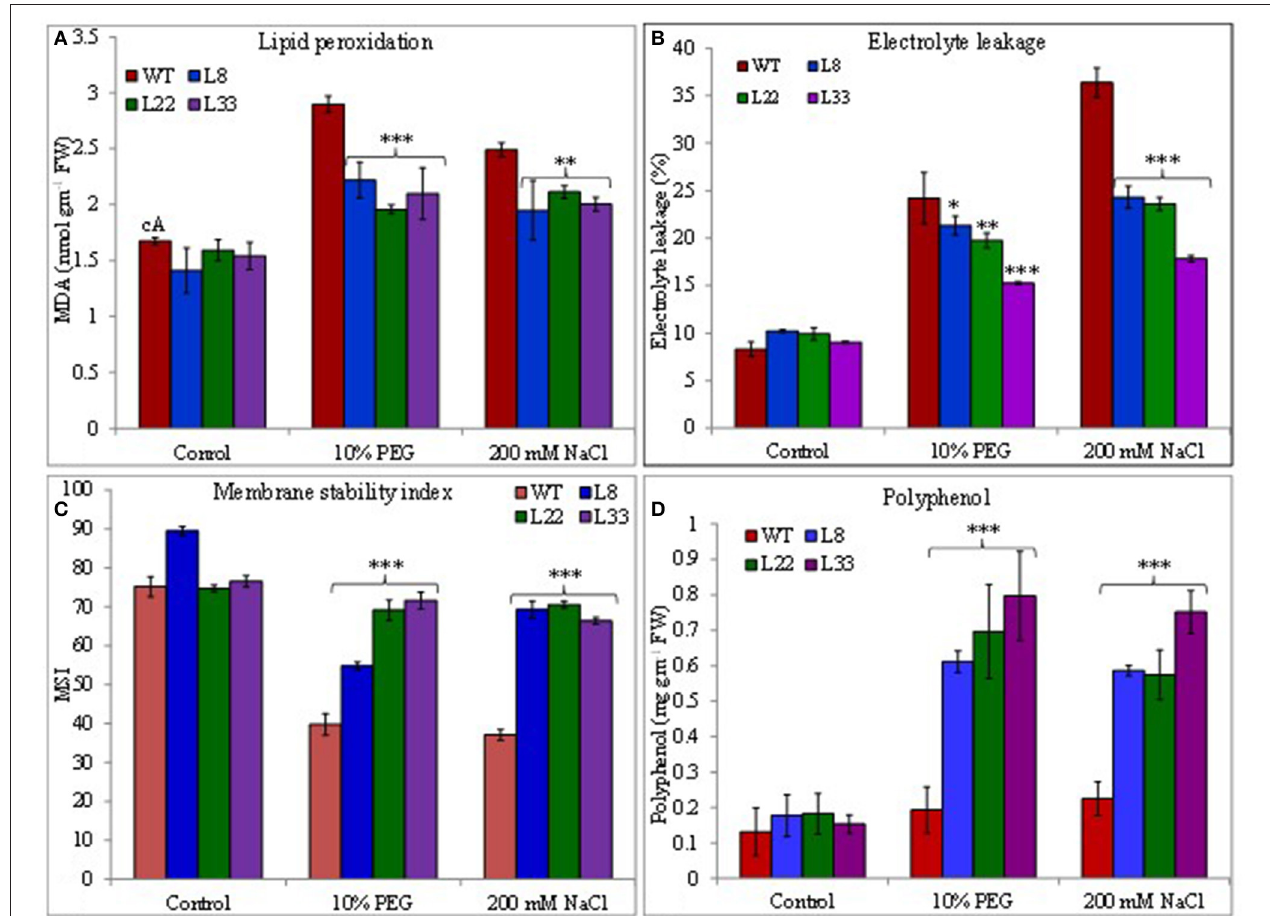
FIGURE 7 | Comparison of (A) lipid peroxidation, (B) electrolyte leakage, (C) membrane stability index, and (D) polyphenol contents in WT and transgenic tobacco under control and stress (drought and salt) conditions. The *, **, and *** denote statistical significance in responses of transgenic lines against control at P value ≤ 0.05, 0.01, and 0.001